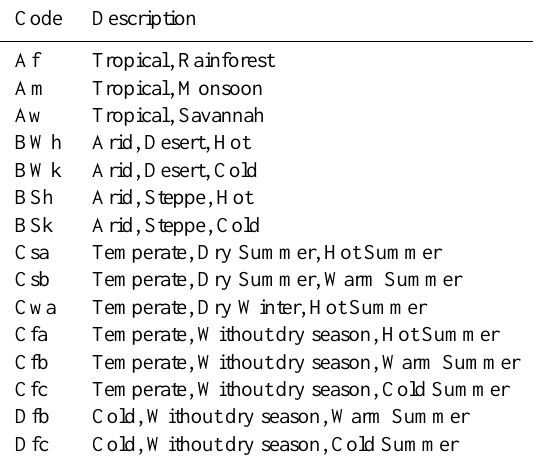
Table 1. Description of the K¨oppen-Geiger climate types in Aus- tralia, see Peel et al. (2007) for classification criteria.